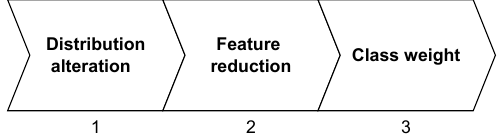
Figure 1. An overview of the proposed